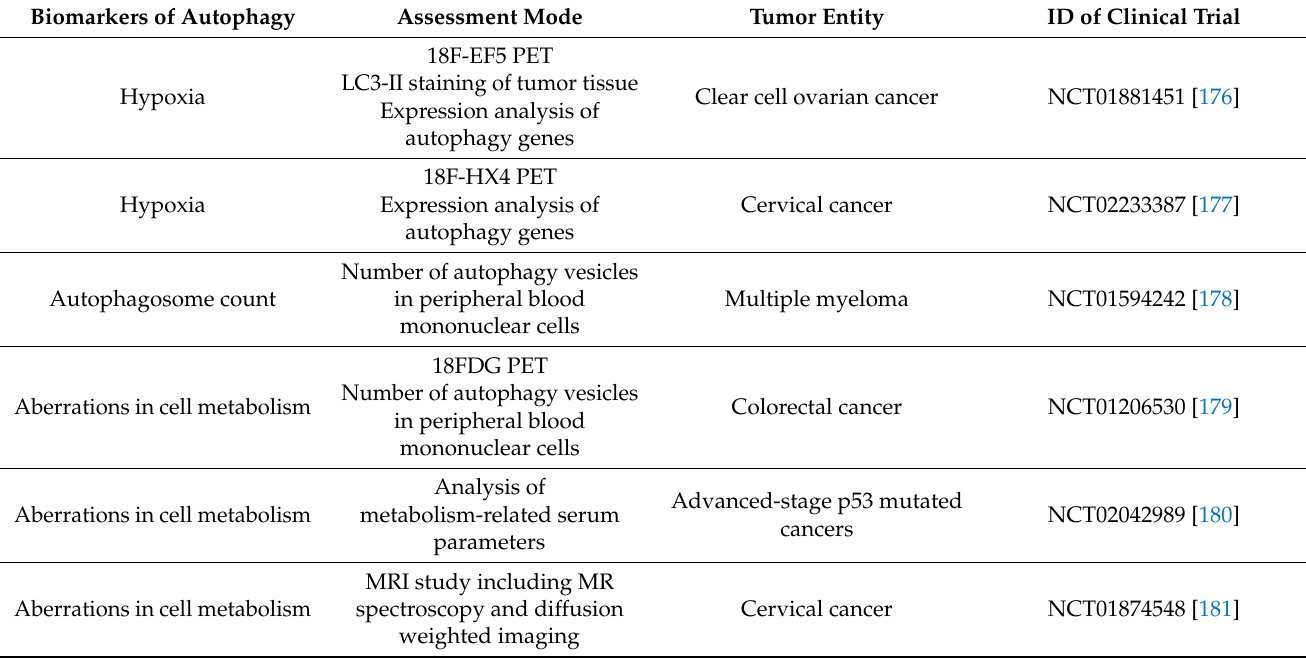
Table 1. Current trials on the investigation of autophagy biomarkers. Table adapted after Levy et al.